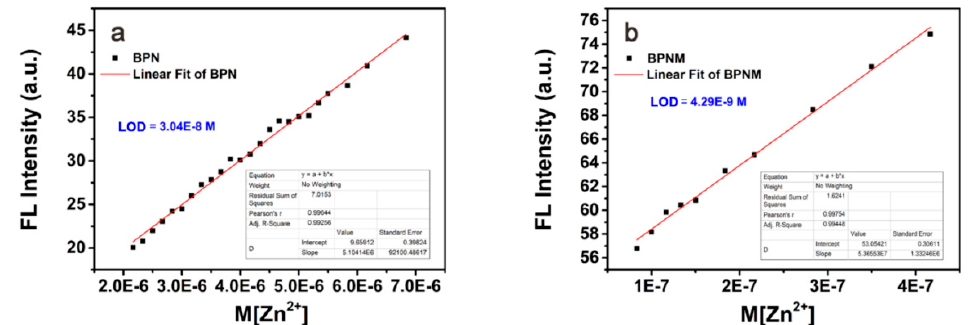
Figure 2. Determination of ( a ) BPN and ( b ) BPNM detection limit.